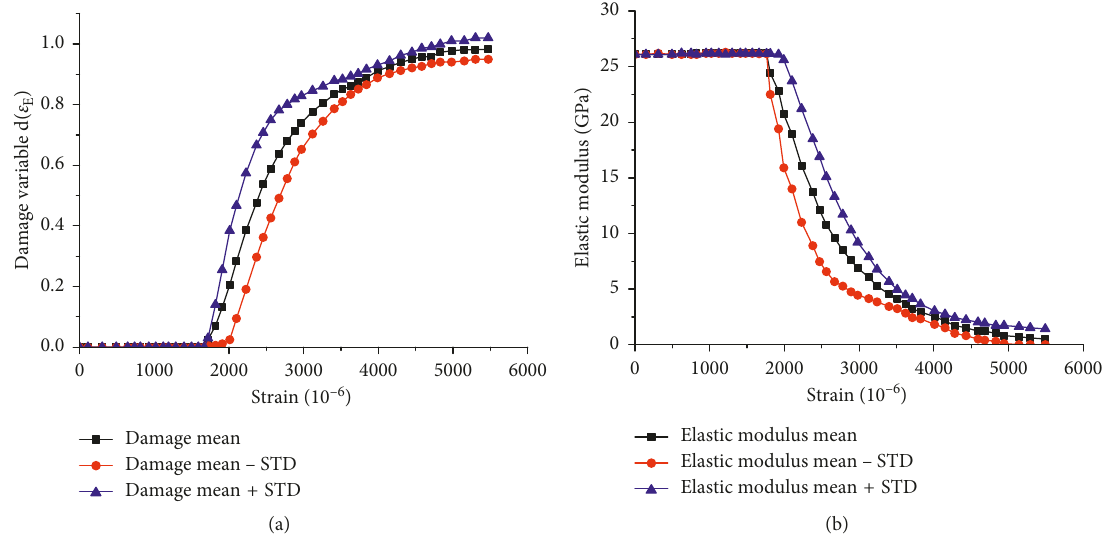
Figure 10: SE of damage variable d ( ε the proposed model. (a) SE of the damage variable d ( ε